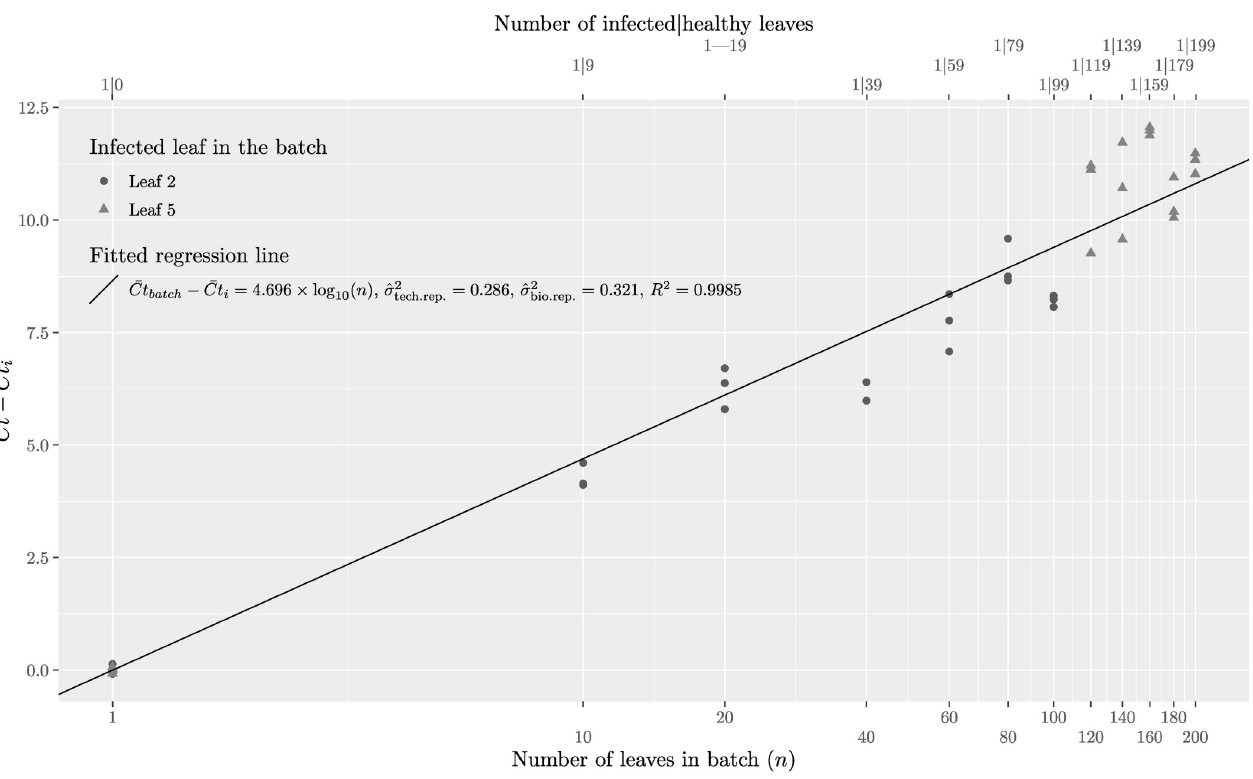
Fig 3. Relationship between number of leaves in a mixed batch of leaves and increase in Ct where batches comprise a single ASBVd-infected leaf pooled with healthy avocado leaves.